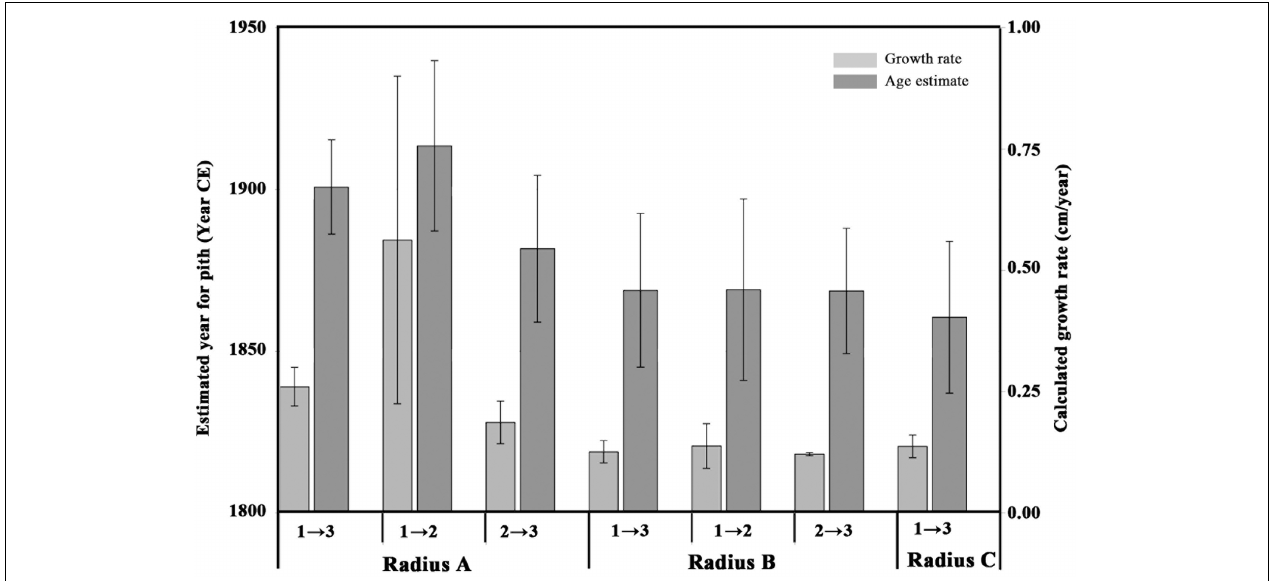
FIGURE 3 | Estimated pith age according to different points and different radii. Light gray bars indicate growth rate (cm per year, axis to the right) calculated between different points on various radii, numbered as in Figure 2 : point 1 refers to the sampling point closest to the pith; point 3 refers to the sampling point closest to the bark; point 2 is the middle sampling point. Dark gray bars represent estimated ranges for the pith age (years, axis to the left), calculated according to the corresponding growth rate values. The error bars on the light gray bars (growth rate) represent the range between the minimum and maximum growth rate as explained in Table 2 . The error bars on the dark gray bars (age estimate) represent the range between the minimum and maximum pith age based on the growth rate ranges.